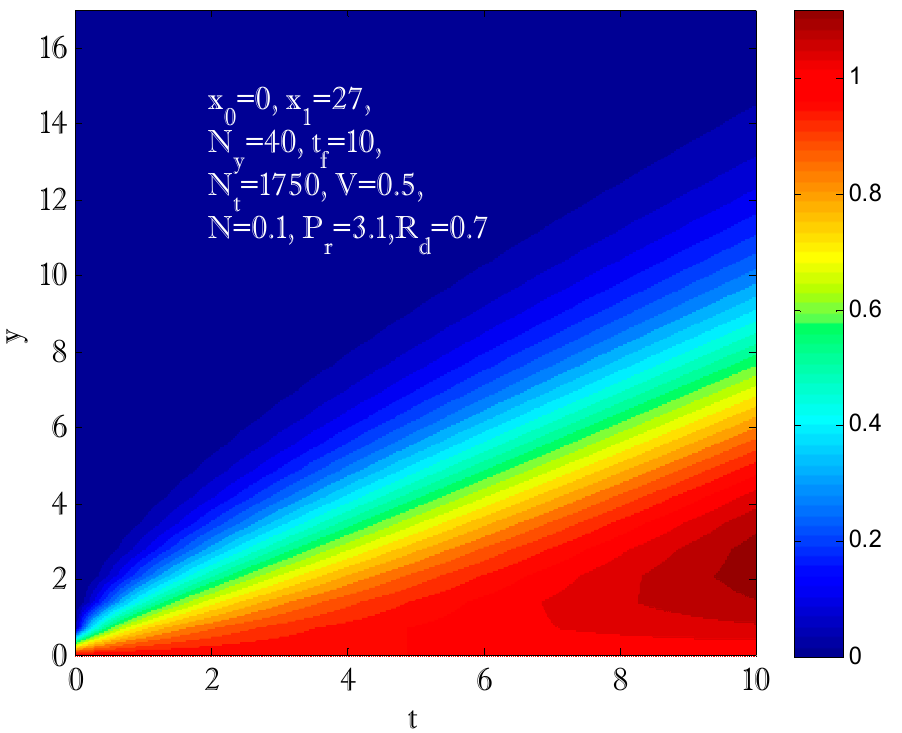
Figure 5. Contour plot for velocity using V = 0.